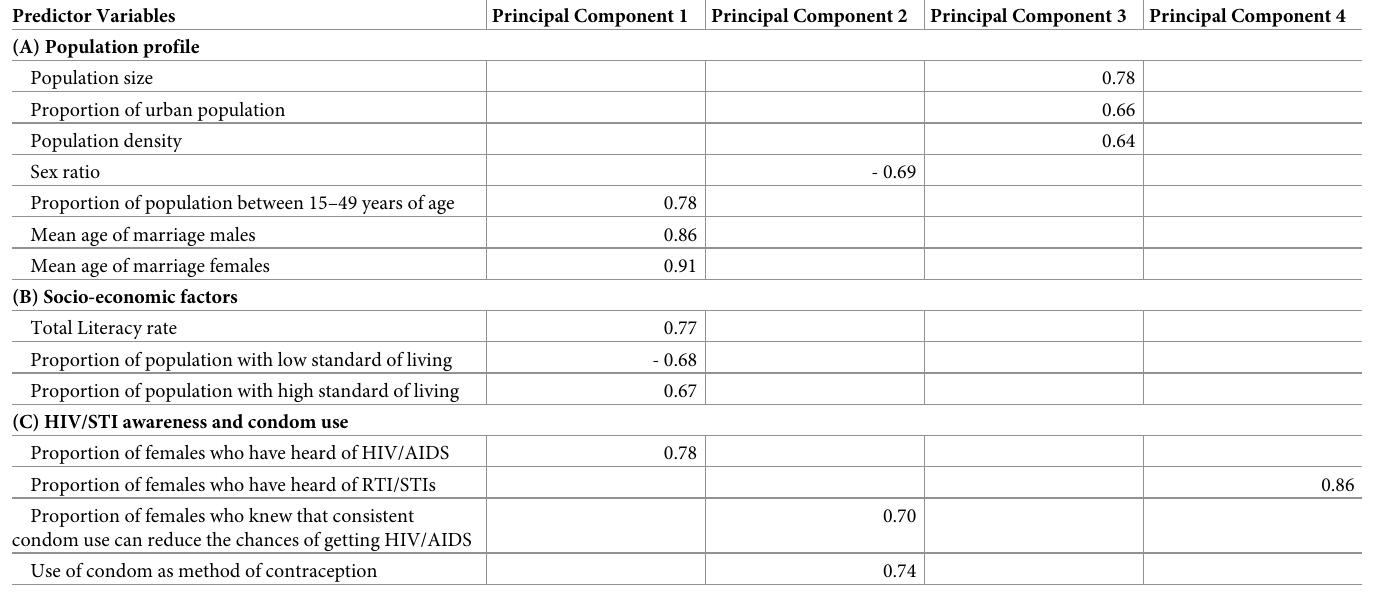
Table 2. Principal component analysis with varimax rotation—significant